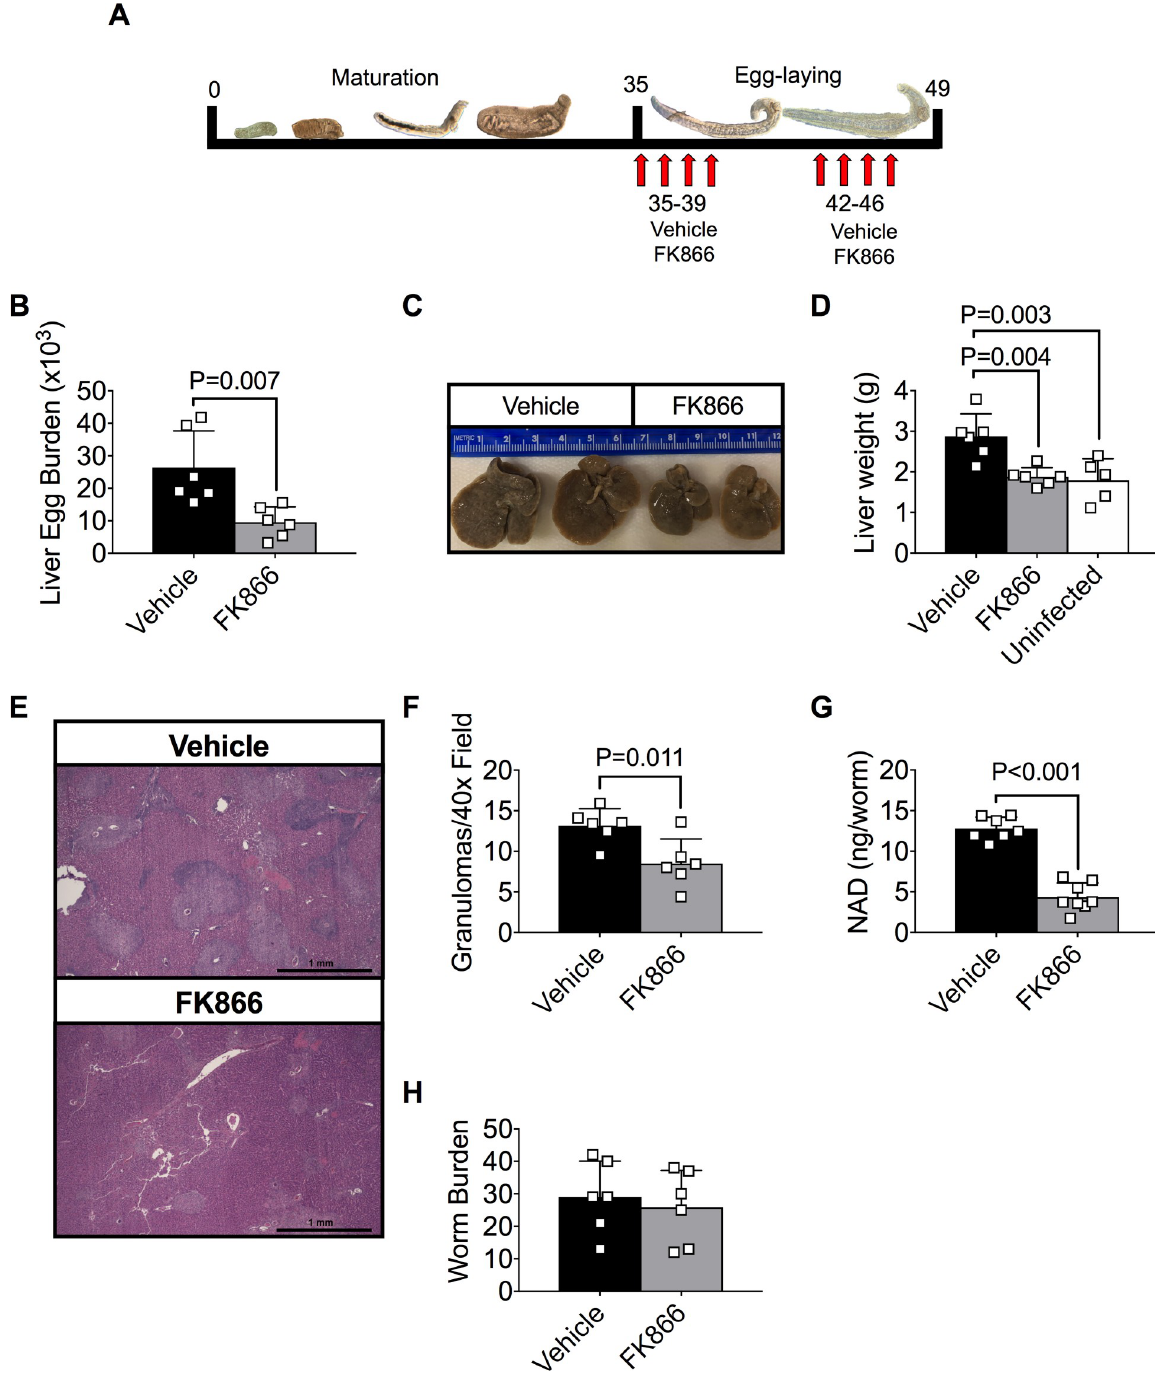
Fig 6. FK866 treatment reduces egg burden and liver pathology in S . mansoni -infected mice. (A) Schematic showing treatment schedule for mice infected on day 0 with ~200 S . mansoni cercariae. Mice were injected (i.p.) with vehicle (45% propylene glycol, 5% tween-80 and 50% ddH2O) or 20mg/Kg FK866 2x/day for 4 consecutive days beginning on day 35. Following a 3-day rest period, animals were injected for an additional 4 days with FK866 or vehicle and then analyzed on day 49. (B) Egg burden in liver of vehicle and FK866-treated groups. Data reported as the total number of eggs per infected liver. n = 5–6 mice/group. (C-D) Hepatomegaly in vehicle and FK866-treated groups. Representative images of livers from infected mice (C) and liver weights (D) are shown. n = 5–6 mice/group. (E-F) Quantitation of granulomas from livers of vehicle and FK866-treated groups. Representative H&E stained cross sections (E) of livers from infected mice and numbers of granulomas per 40x field (F) as determined by blinded assessment of H&E cross sections. n = 6 mice/group. (G) Intracellular NAD levels in parasites flushed